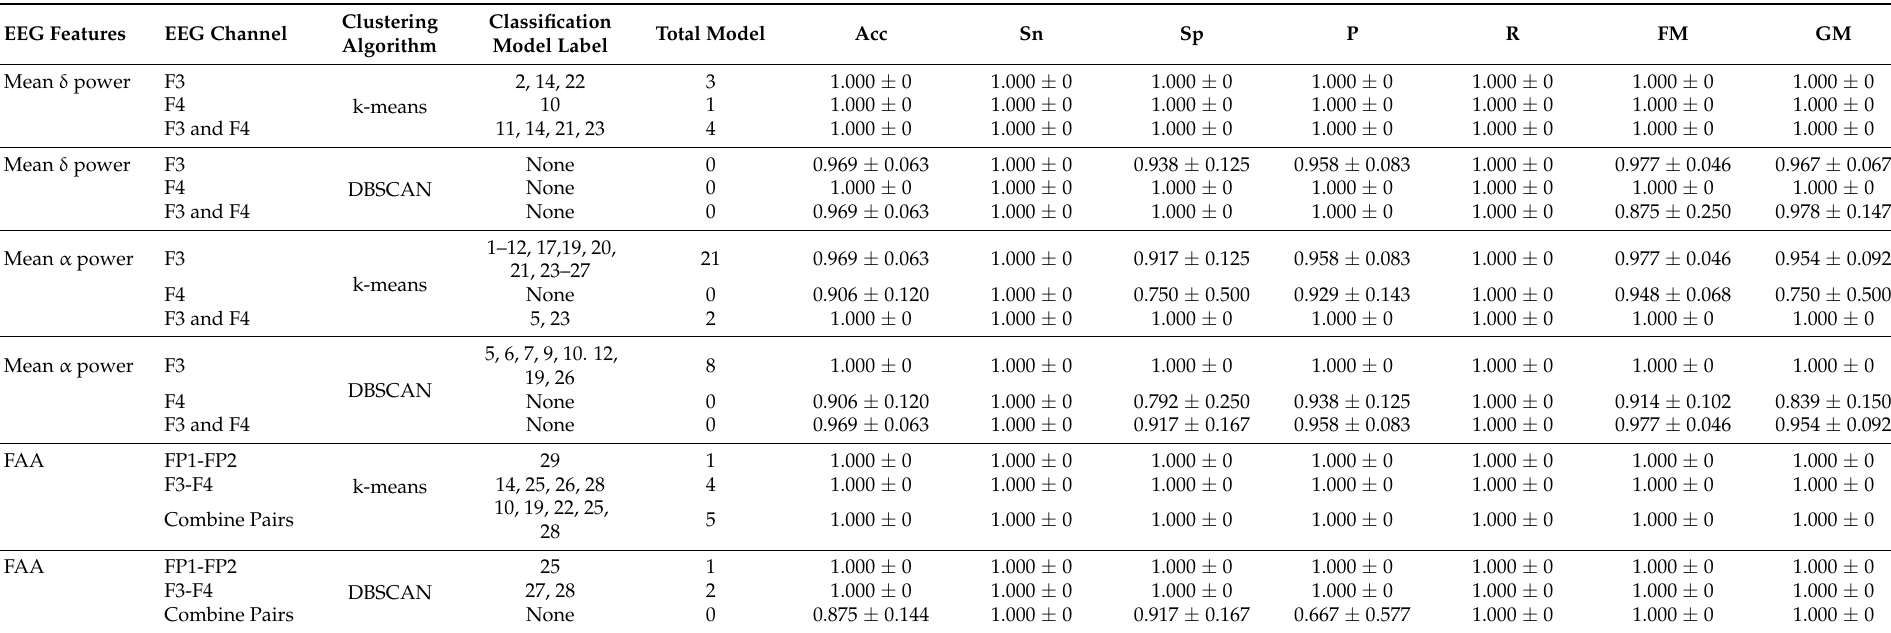
Table 8. The classification model with the highest value in all performance assessment parameters across the